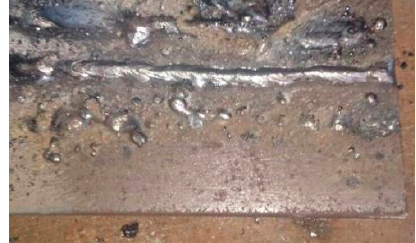
Figure 14. Student’s Work Failed in Examination.